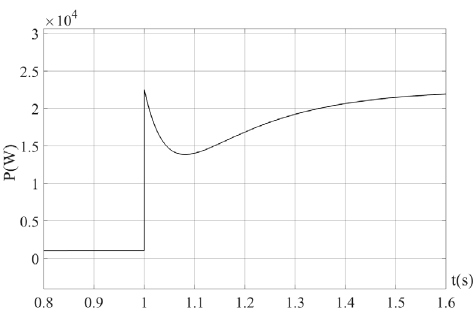
Figure 10. AC constant power load generates a power step (Group A).